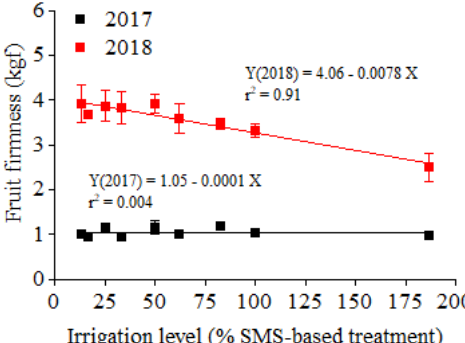
Figure 6. E ff ect of irrigation level on fruit fi rmness in 2017 and 2018. Data are means of three replicates ± standard errors. SMS = soil moisture sensor. Linear regression models for each year are displayed in the figure.